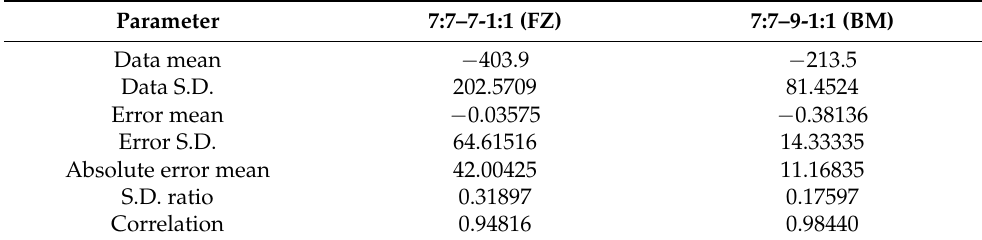
Table 8. Regression statistic of the ANNs analyzed.